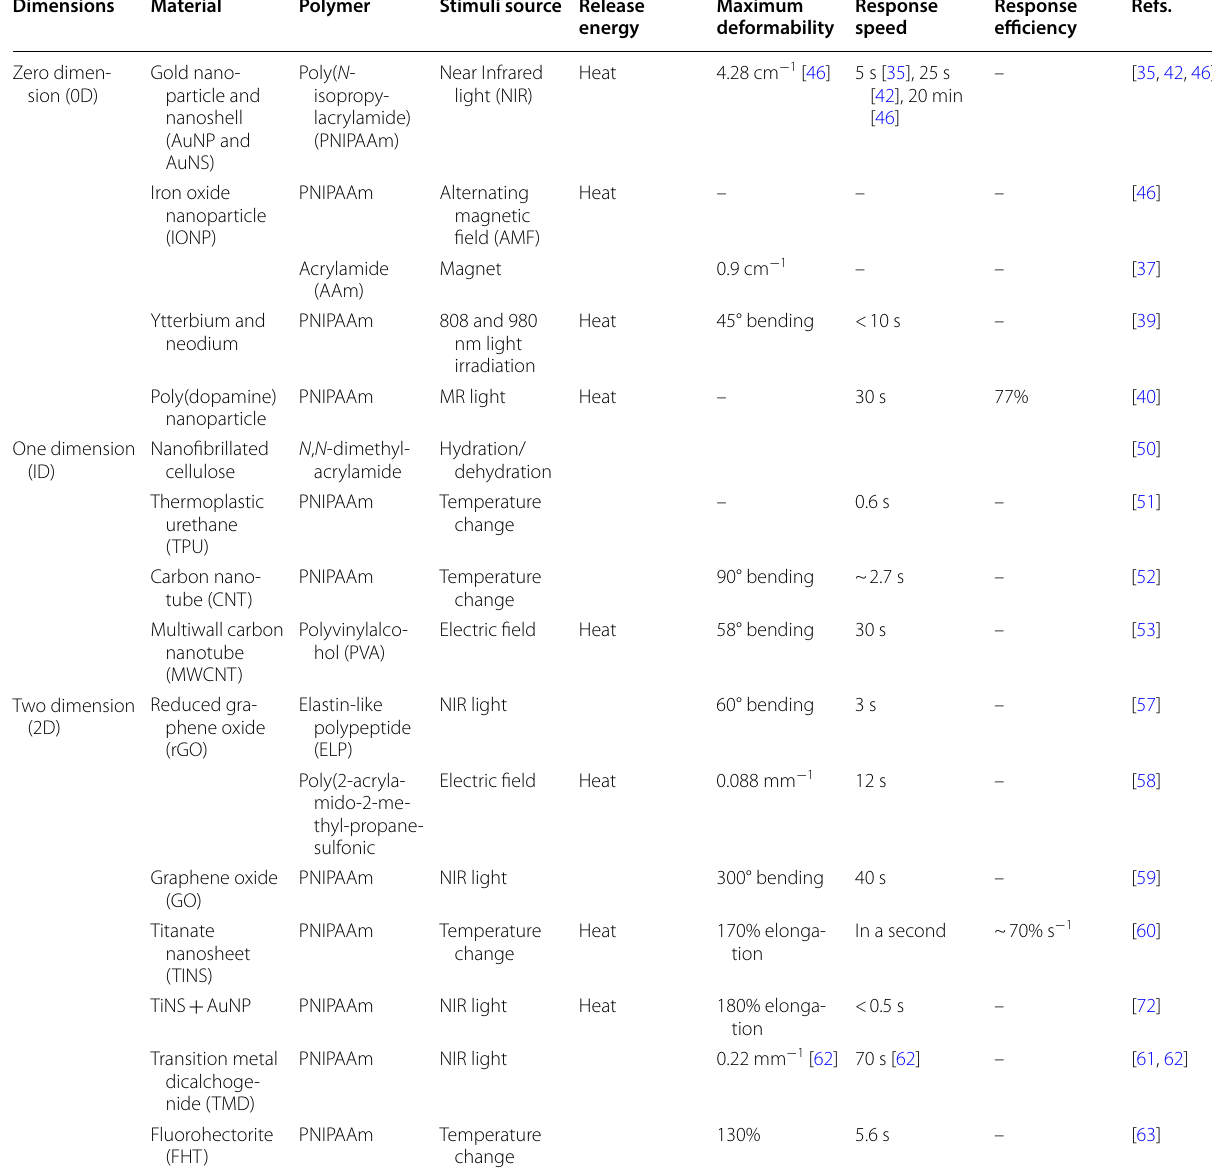
Table 1 Classification of additives, polymers, and required stimuli of the hydrogel actuators and actuation comparisons in terms of their maximum deformability, response speed, and response efficiency